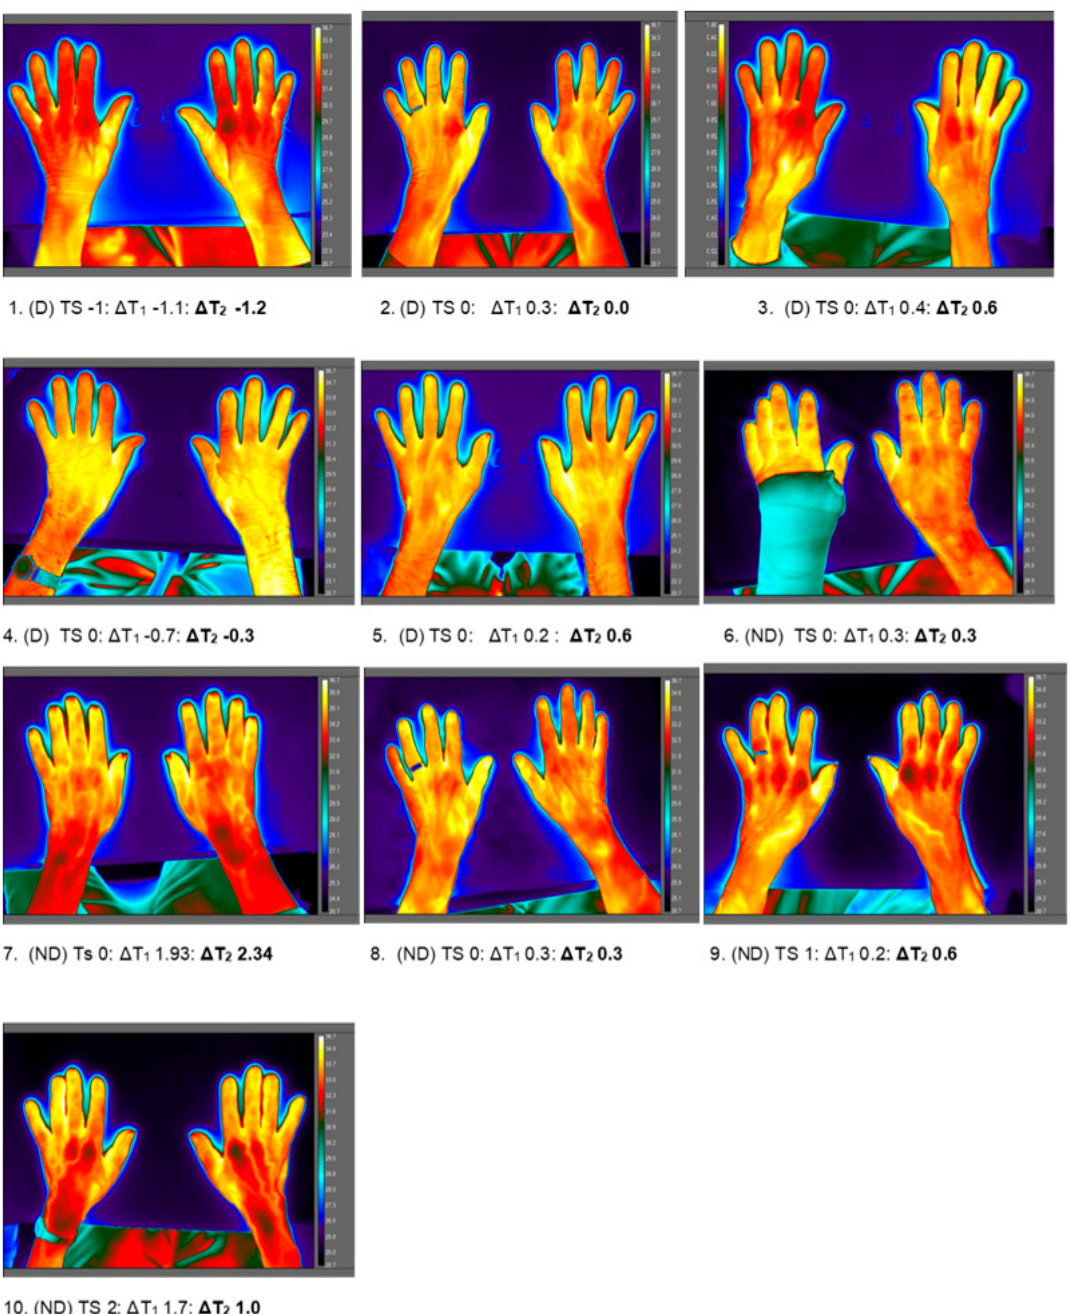
◦ C; ◦ ◦ ◦ C to 25.3 C (median 22.9 C) i.e., similar air temperature ◦ ◦ ◦ C to + 1.9 C (median 0.3 C). Similarly, for ∆ T 2 , ◦ ◦ ◦ C to + 2.34 C (median 0.45 C). Int. J. Environ. Res. Public Health 2020 , 17 , x